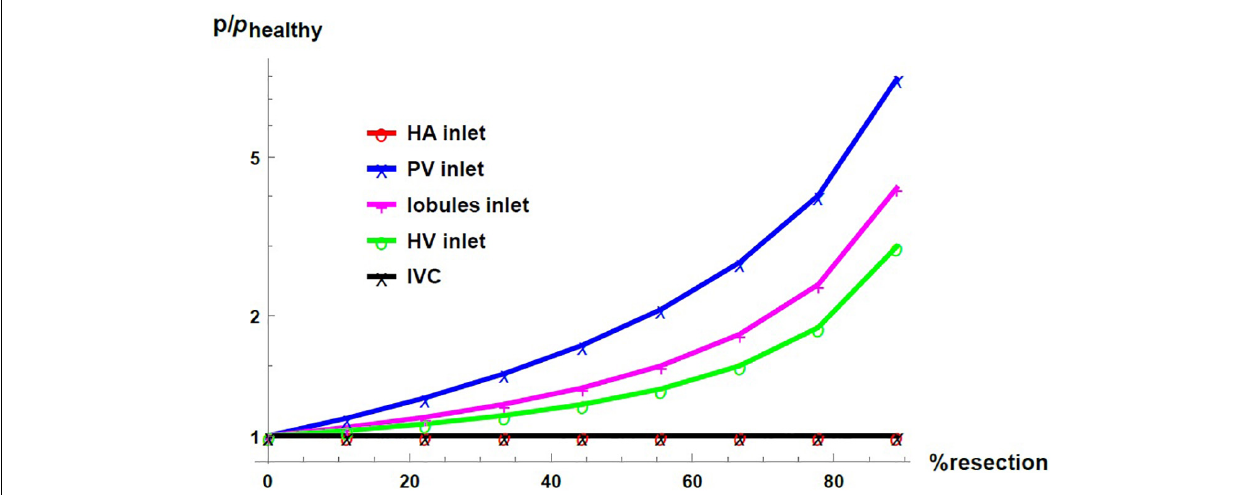
FIGURE 7 | Pressure as a function of the resection percentage in different locations of the liver. The pressure is normalized by its corresponding value in the healthy